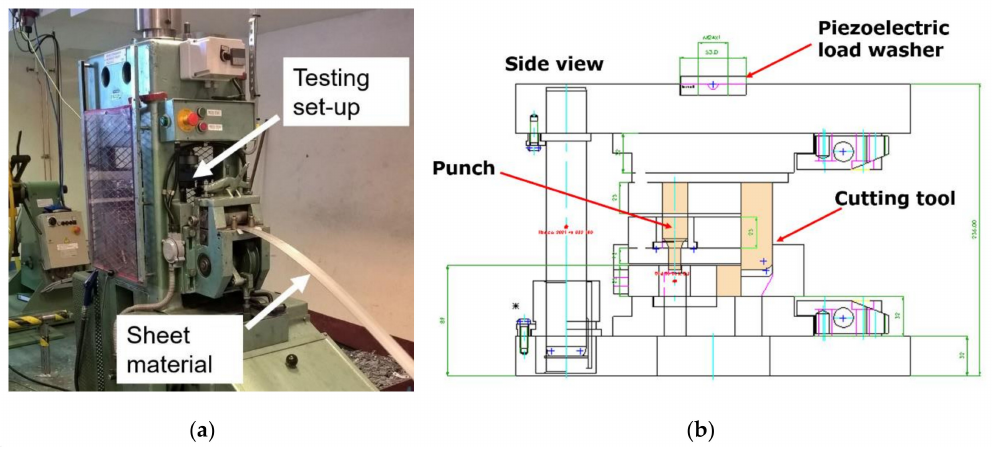
Figure 3. Semi-industrial punching test set-up: ( a ) Uddeholm’s 15 ton punching test rig and ( b ) a schematic view of the testing set-up.